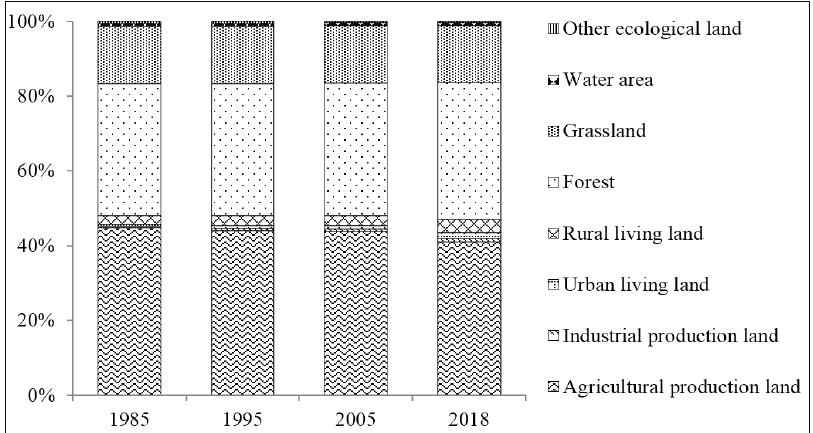
Figure 6. Carbon sequestration in the BTH region in 1985, 1995, 2005, and 2018.